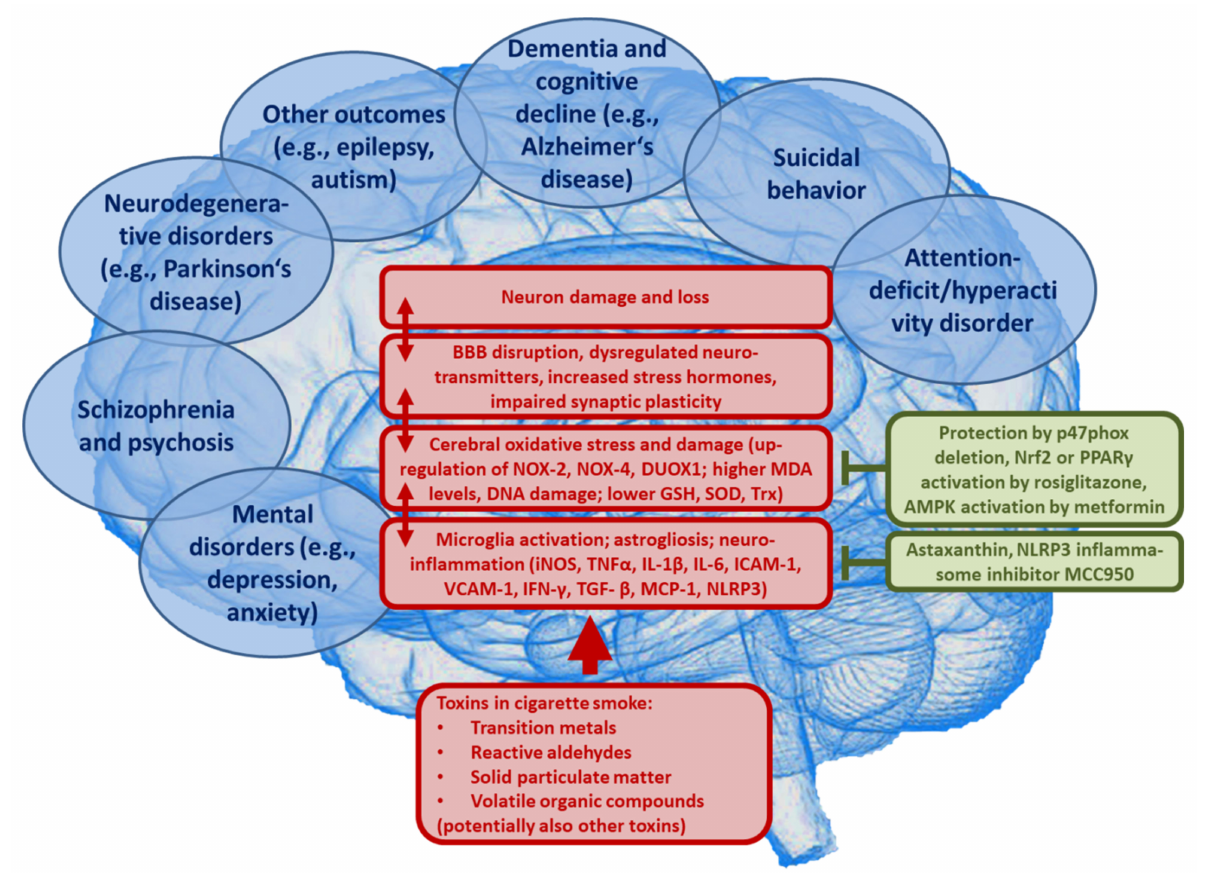
Figure 5. Proposed concept how the major toxins in cigarette smoke may contribute to neurological complications and neuronal/psychiatric diseases. Uptake of fine particulate matter, heavy/transition metals, reactive aldehydes, volatile organic compounds, and other cigarette smoke toxins leads to neuroinflammation and cerebral oxidative stress by microglia activation, impairing vital pathways in the brain, and initiating pathophysiological processes such as amyloid deposition and neuron damage and loss. BBB, blood-brain barrier; iNOS, inducible nitric oxide synthase; TNF α , tumor necrosis factor alpha; IL-1 β , interleukin 1beta; IL-6, interleukin 6; NOX-2, NADPH oxidase isoform 2 (phagocytic NADPH oxidase); NOX-4, NADPH oxidase isoform 4; DUOX1, dual oxidase 1; MDA, malondialdehyde; GSH, glutathione; SOD, superoxide dismutase; Trx, thioredoxin; VCAM-1, vascular cell adhesion molecule 1; ICAM-1, intercellular adhesion molecule 1; MCP-1, monocyte chemotactic protein 1 (CCL2); TGF- β , transforming growth factor beta; IFN- γ , interferon gamma; NLRP3, NLR family pyrin domain containing 3; p47phox, regulatory subunit of NOX-2 and NOX-1; Nrf2, nuclear factor E2 related factor-2; PPAR γ , Peroxisome proliferator-activated receptor gamma; AMPK, AMP-activated protein